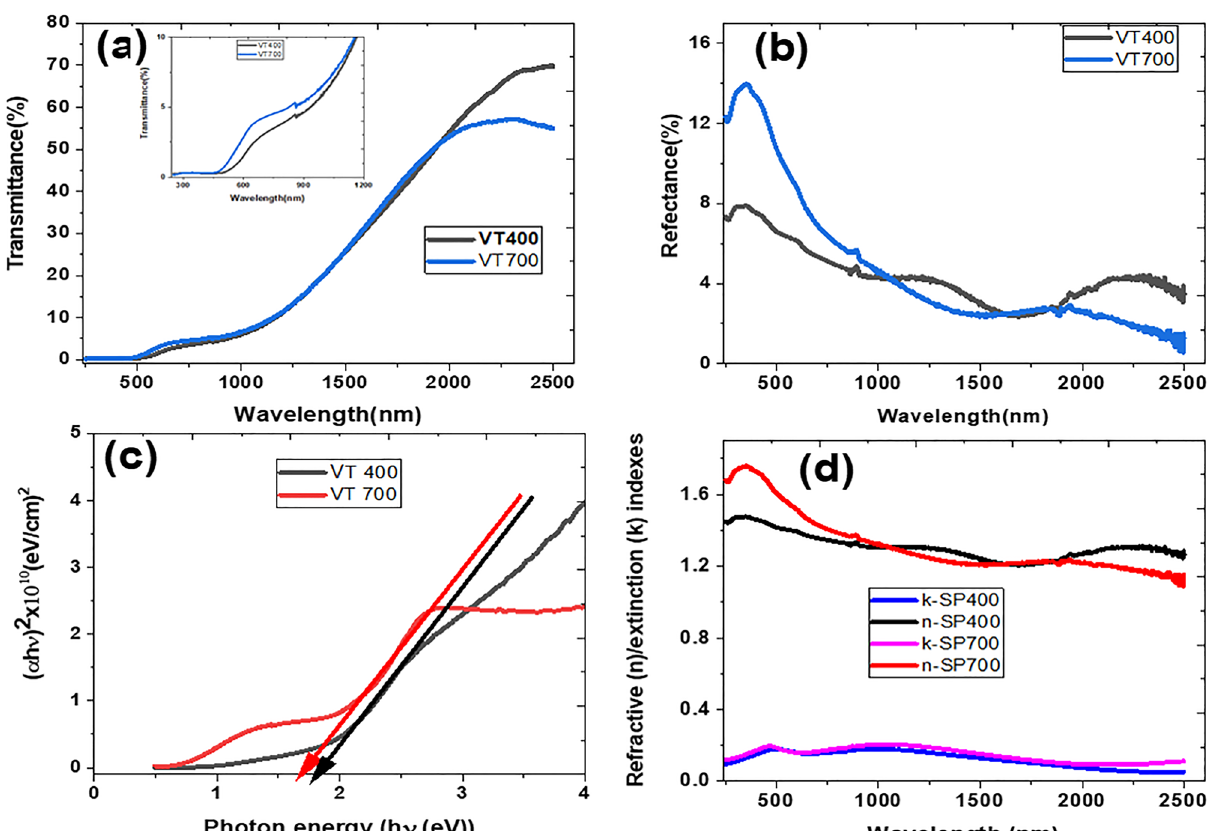
Figure 5. NIR optical properties of VO 2 thin films deposited on silica substrate at different temperatures of 400 and 700 °C; ( a ) Transmittance, ( b ) reflectance, ( c ) optical band gap for n = 1 / 2 , and refractive